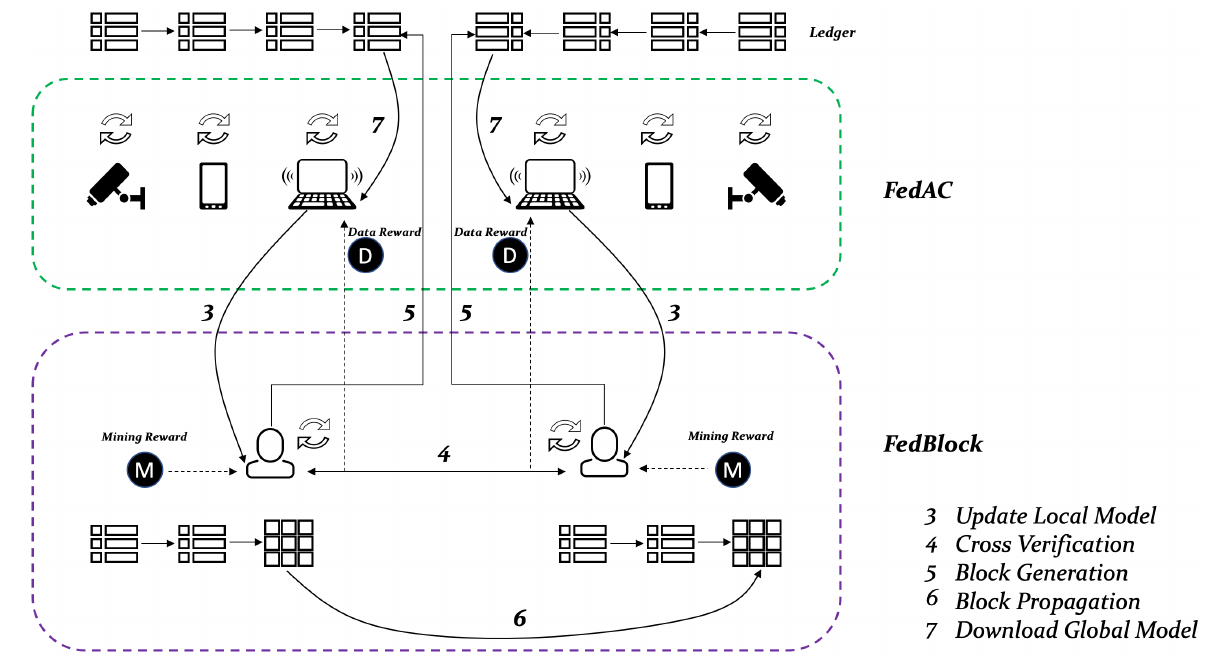
Figure 1. Workflow of FedAC and